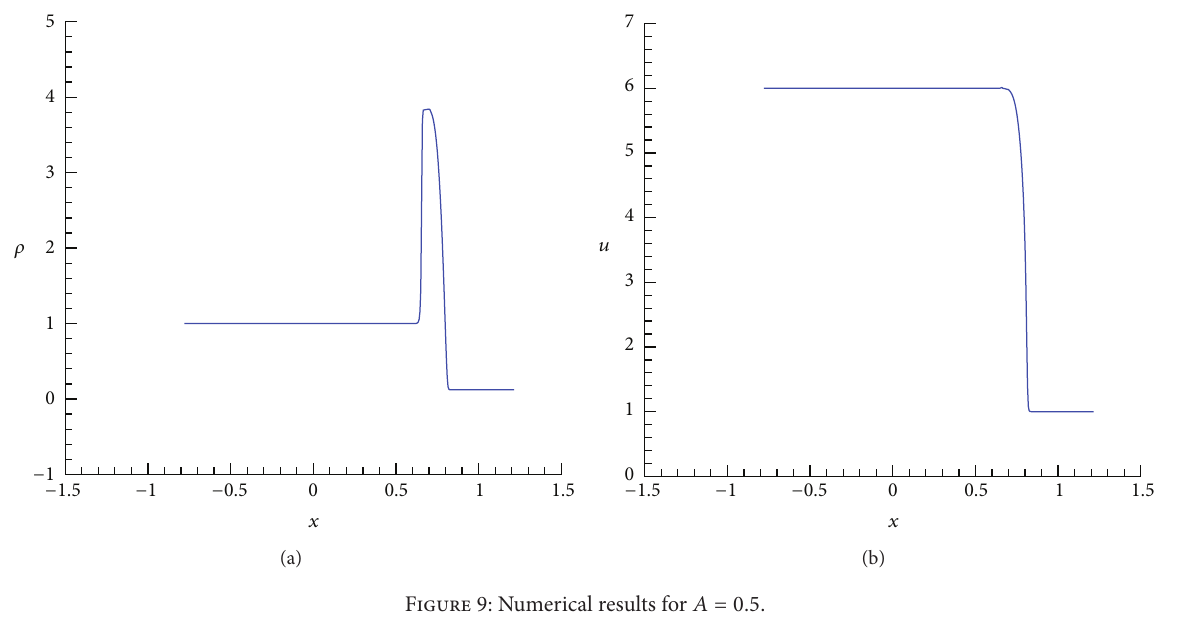
Figure 9: Numerical results for 𝐴 = 0.5 .